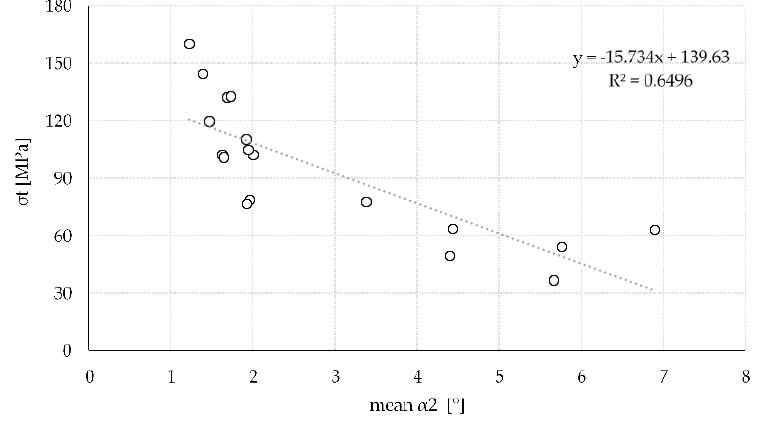
α 2 on the tensile strength of n = 18 samples (r = − Figure A1. Influence of mean α2 on the tensile strength of n = 18 samples (r = -0.806). Figure A1. Influence of mean